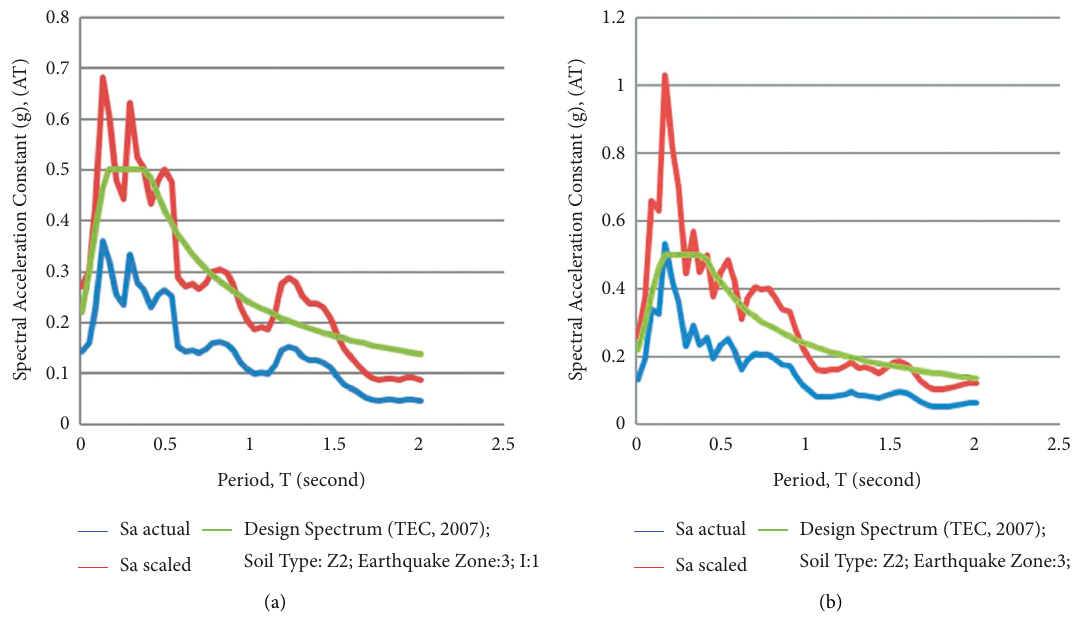
Figure 18: Evaluation of A(T) spectral acceleration constants for (a) North-South (N-S) and (b) East-West (E-W) components of earthquake with epicenter at Kayseri-Kocasinan ( M D : 3.7).